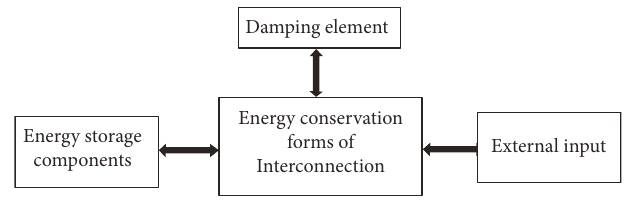
Figure 1: Internal interconnection